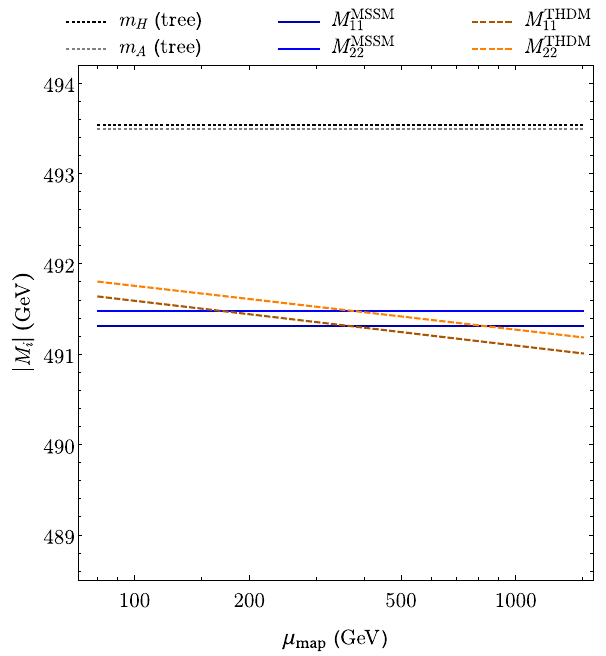
Fig. 5 Themassdeterminationisshownforthedegenerate ( H , A ) sys- = 3 π tem of Fig.4 with ϕ A through a mapping of the Higgs self- 20 t energies onto a THDM+SUSY model. The dotted lines correspond to the (MSSM) tree-level values and the horizontal blue lines to the MSSM loop-corrected evaluation employing Eq.(12). The dashed lines are obtained with self-energies that are calculated in a THDM where the Higgs potential takes tree-level masses that coincide with the loop- corrected mass value that are injected as external momenta and tree- level fields including the S rotation. The parameters of this THDM are determined from the conditions of Eq.(46) together with the (arbitrary) ≡ 0, λ r ≡ 0. The dependence on μ constraints λ 1 ≡ λ 2 , λ r , i map orig- 6 7 inates in the freedom of scheme for the fixing of the renormalization conditions of these Higgs-potential parameters and can be seen as a symmetry-conserving uncertainty on the